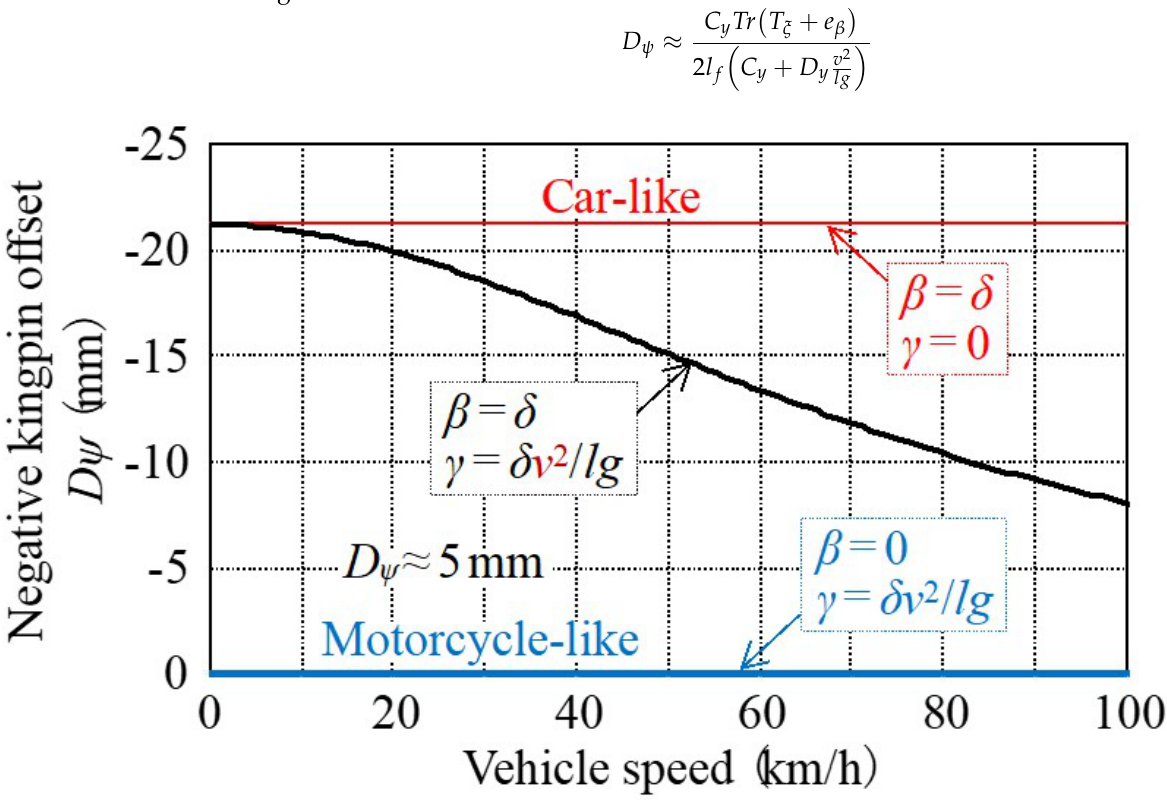
Figure 7. D ψ to minimize yaw moment disturbance by one-side